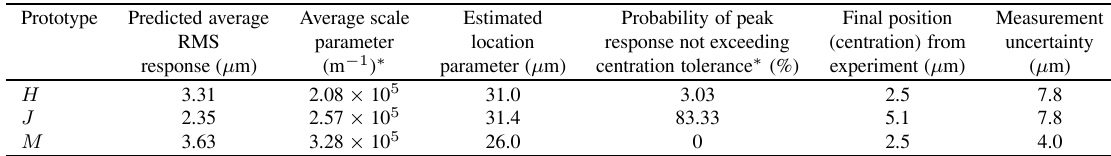
Table 2 Peak response statistics and comparison to prototype experimental data